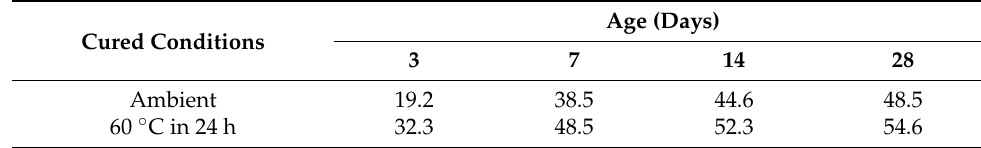
Table 5. Compression strength of geopolymer paste